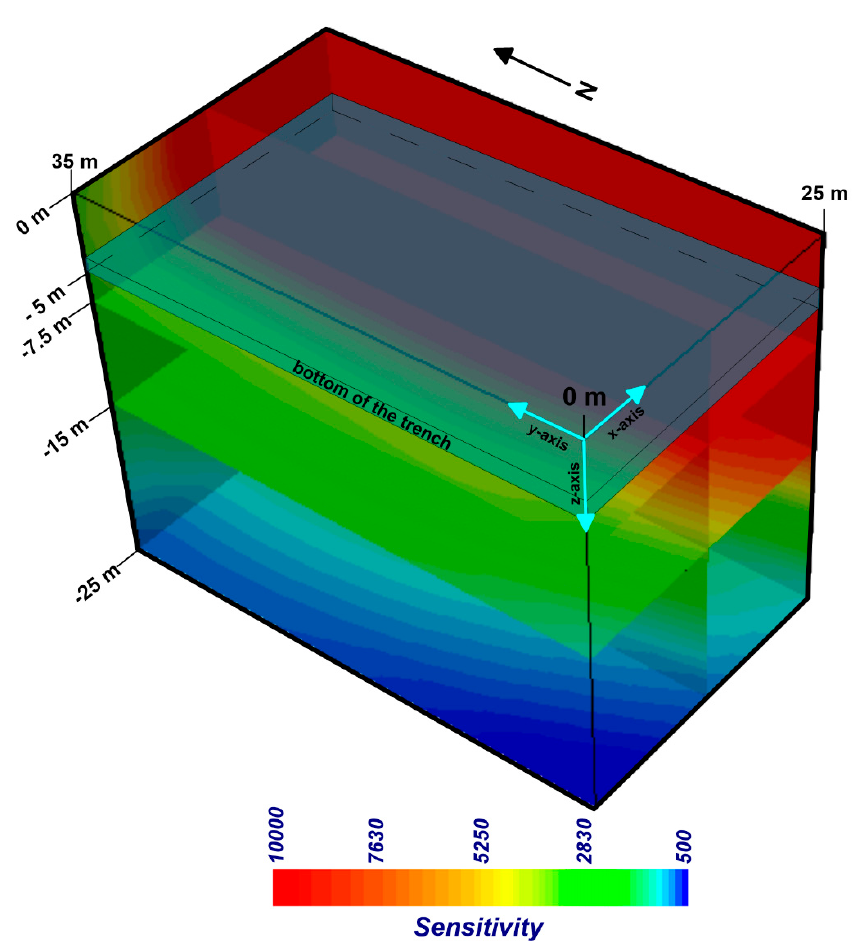
Figure 6. Three-dimensional sensitivity model below infiltration Trench 9.